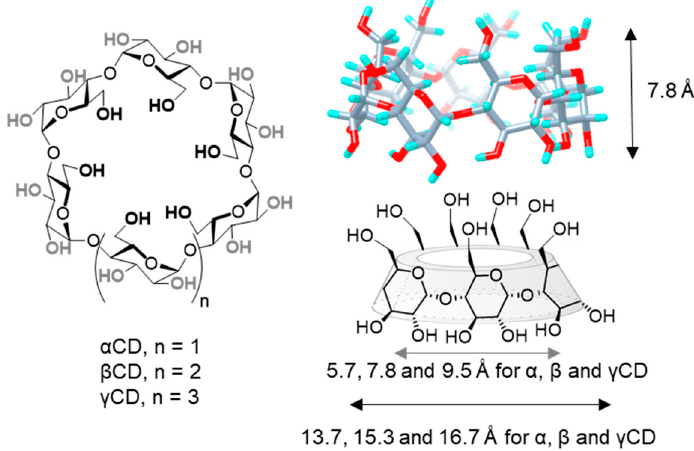
Figure 1. Structures of α , β and γ CD (left), 3D view of β CD (upper-right) and schematic representation of CD basket-shape architecture (lower right), with indication of the height, and average internal and external diameters for the three commercially available representatives. CD, cyclodextrin.